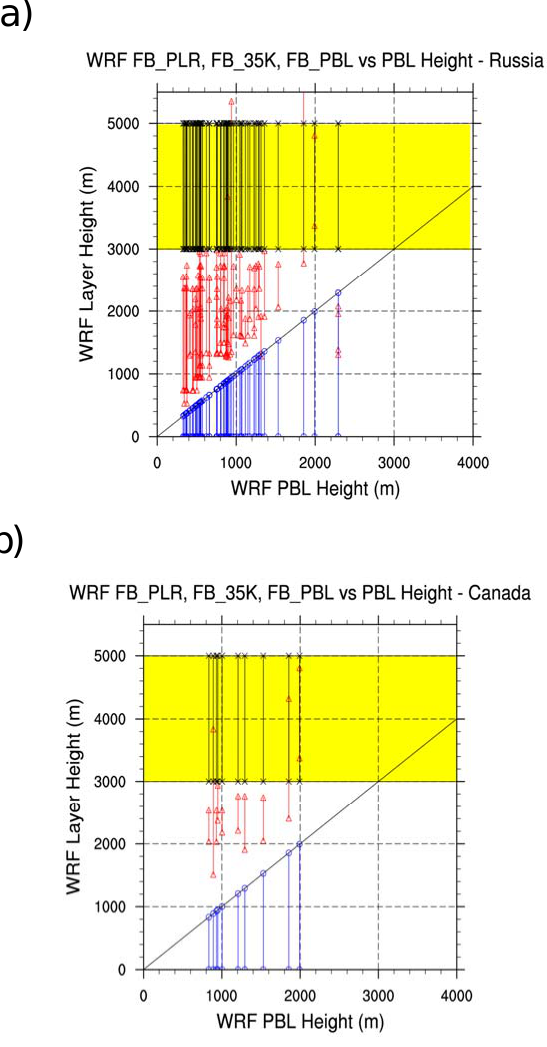
Fig. 9. Simulated injection heights for FB_PLR (red triangles) and FB_PBL (blue circles), and FB_35K (black crosses) plotted against simulated PBL heights from WRF-Chem for a) injections in Russia and b) injections in Canada. The yellow shaded region represents the injection layer for the 35K simulations. Since the emissions were not released at a single altitude, the vertical lines represent the layer over which injection occurred.